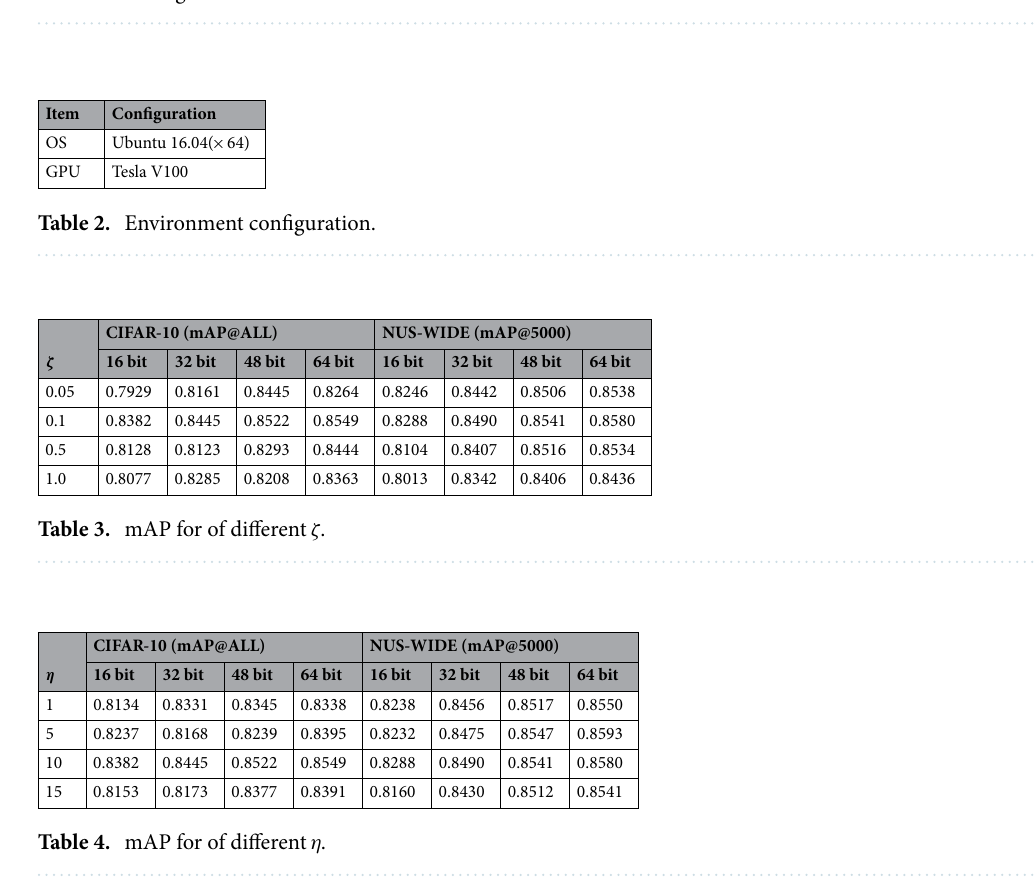
Table 1. Configuration of ResNet18 network.